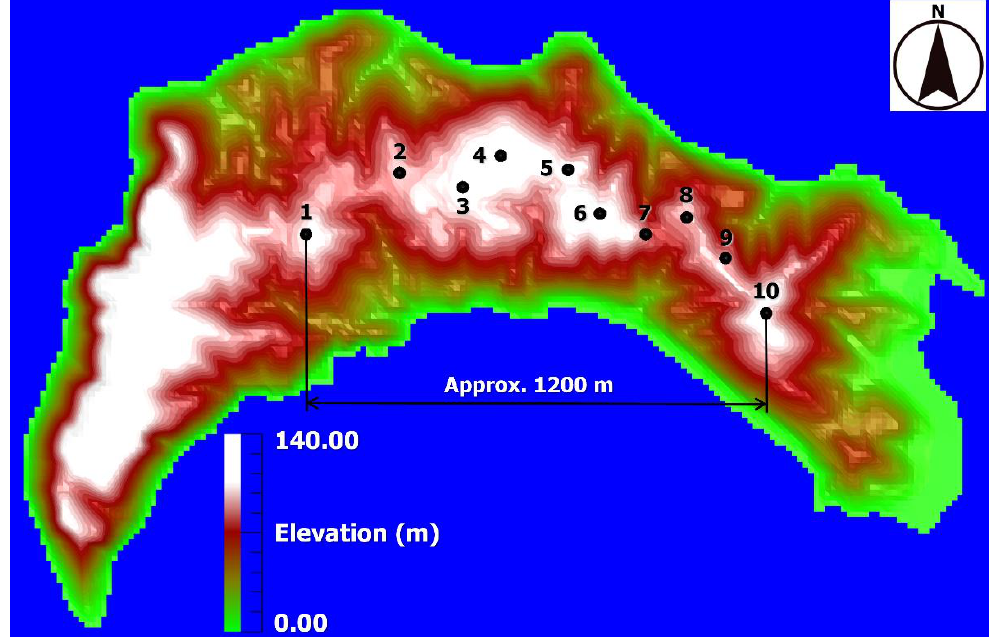
Figure 12. Map of elevations at the wind farm (WF). Table 1. Specifications of wind turbines (WTs) at Noma Wind Park.